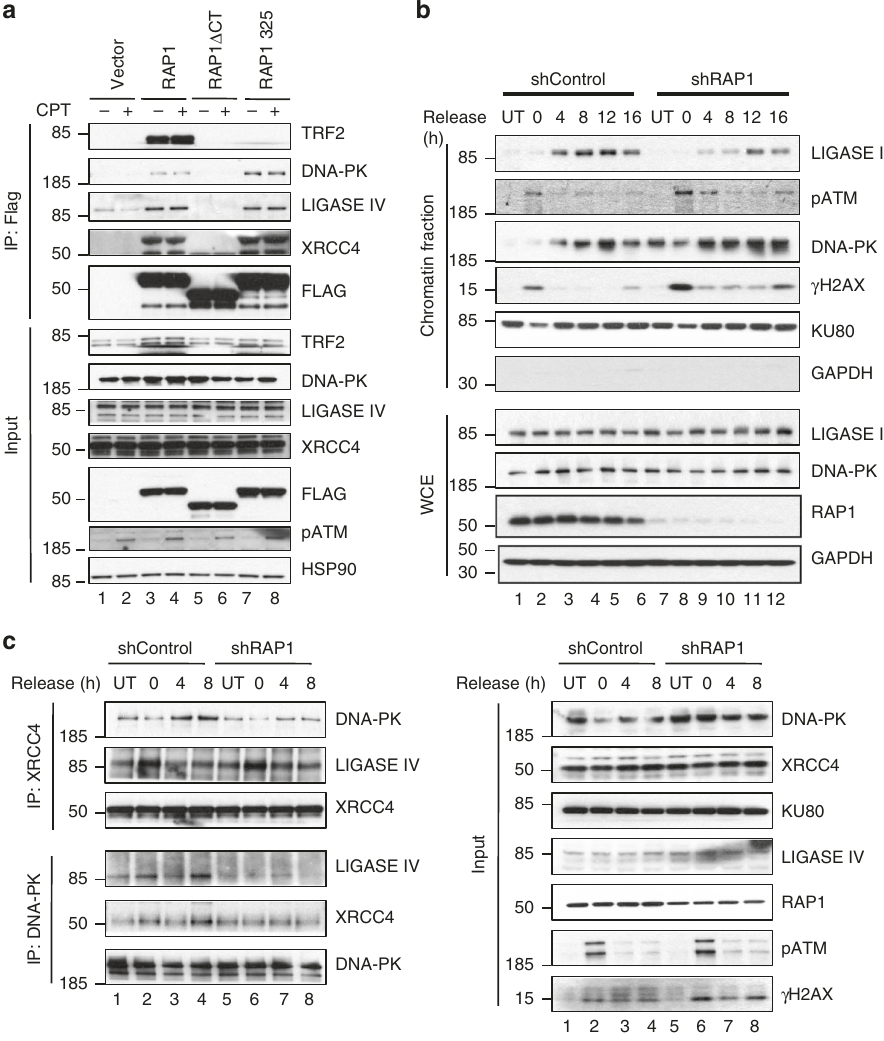
Fig. 5 RAP1 mediates interaction between XRCC4/Lig IV and DNA-PK. a Flag-tagged RAP1 mutants (as indicated) were expressed in cells followed by IP using anti-Flag beads. The IP eluate was immunoblotted for the indicated proteins. Inputs are shown in bottom panel. b MCF7 cells were transfected with shcontrol or shRAP1, and left untreated (UT) or treated with CPT (10 μ M) for 3 h (represented as 0 time point). Following this, cells were released for various time points and fractionated and blotted for indicated proteins. WCE indicated whole-cell extract c Co-immunoprecipitation of lysates from shRAP1 or shControl cells UT or treated with CPT (10 μ M) for 3 h and released for the indicated times. Immunoblots demonstrate association of indicated